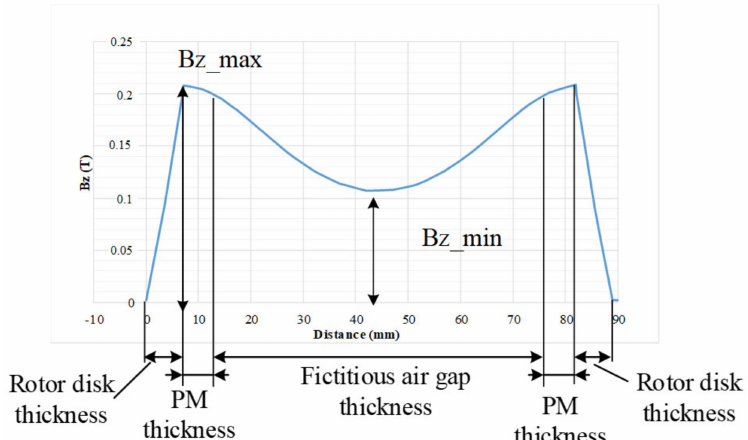
Figure 2. Axial component of magnetic flux density along the centerline (an example is shown at 55 mm virtual air gap thickness, 7 mm rotor disk thickness and 5 mm PM thickness. Values of B z near the PM ( B z_max ) and at the middle of the virtual air gap ( B z_min ) are shown).